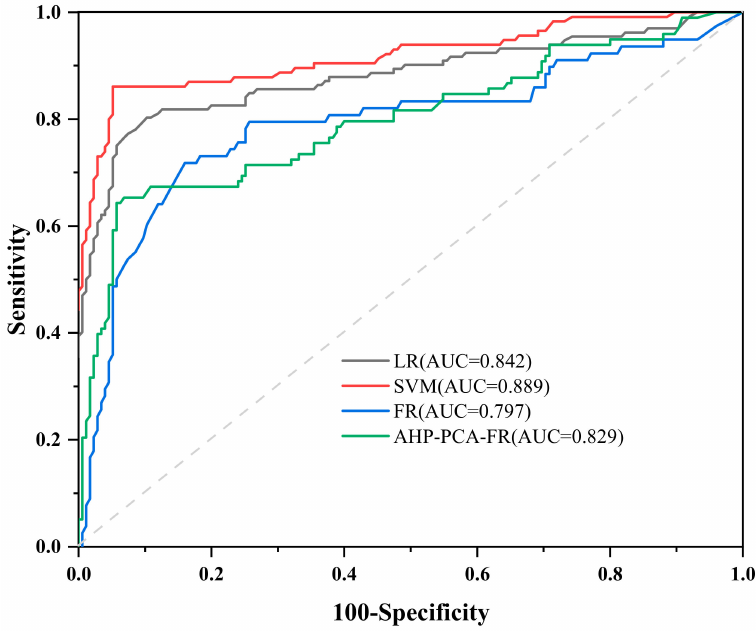
Figure 11. The ROC curves of four debris flow susceptibility